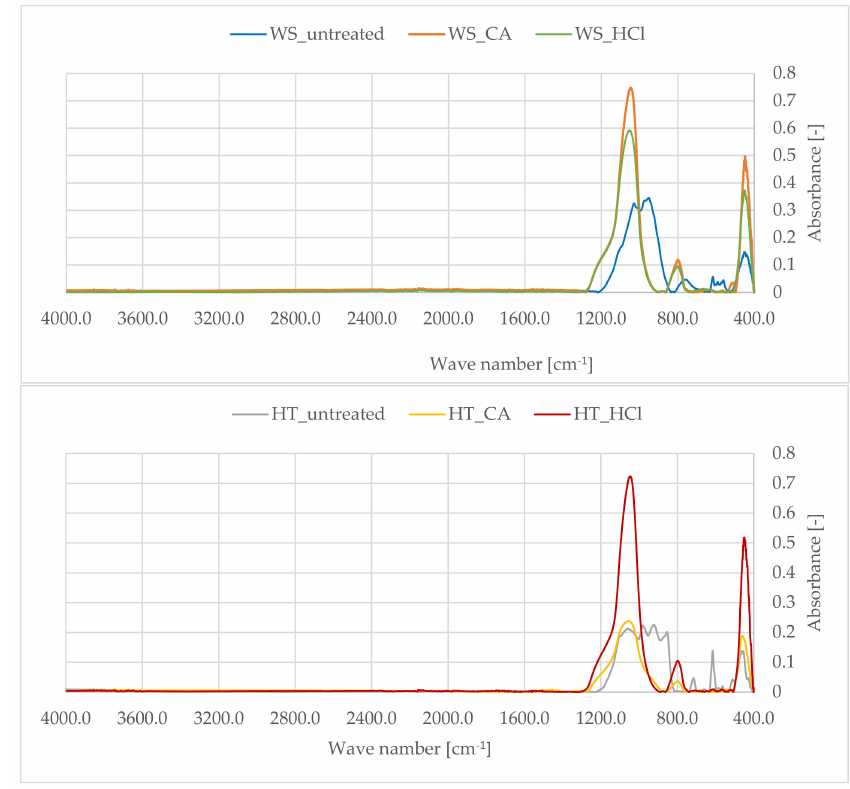
Figure 4. FTIR spectra of plants ashes from wheat straw ( up ) and horsetail ( down